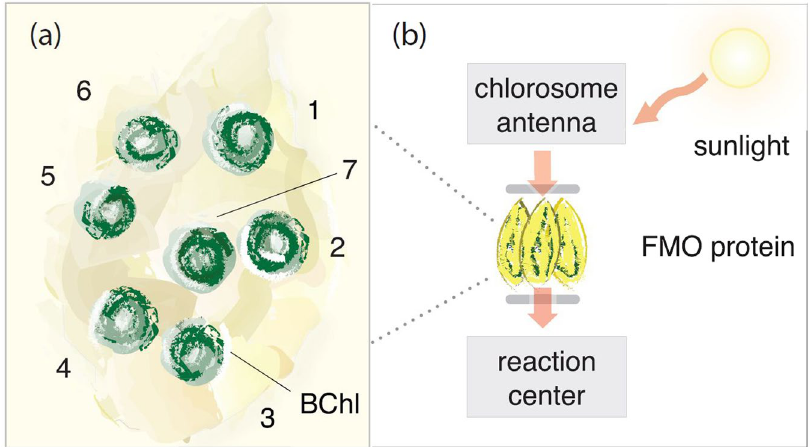
Figure 3. ( a ) Schematic diagram of a single monomer of the FMO protein complex. This monomer contains eight sites (here we show only seven of them). In the bacterial photosynthesis, the excitation from the light- harvesting antenna enters the FMO complex at sites 6 or 1 and is then transferred from one site to another. The excitation can irreversibly jump to the reaction center, when it reaches site-3. In this work, the initial condition is set as site-6 in a mixed excited state while the other sites are in ground states. BChl stands for a bacteriochlorophyll molecule. ( b ) Schematics of how the monomer exists in a trimer, and acts as a wire connecting a large antenna complex to the reaction